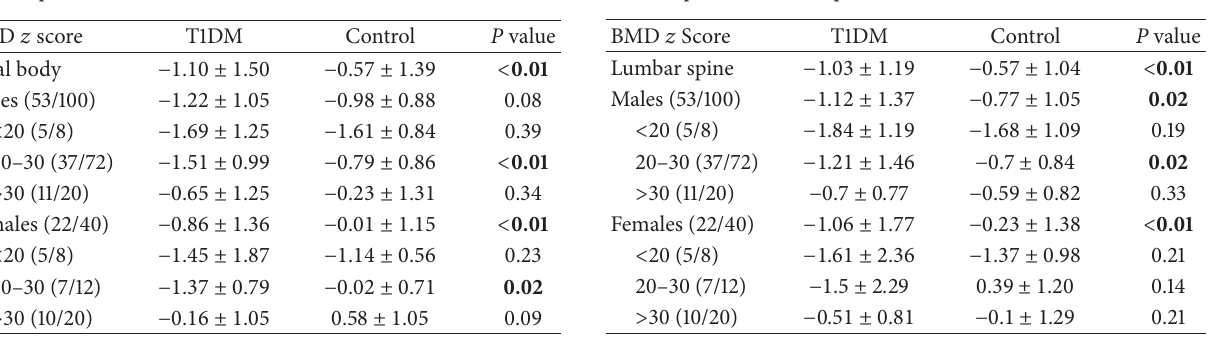
Table 4: Differences in bone mineral density 𝑧 scores in T1DM subjects and age, sex, and body mass index matched controls at lumbar spine (L2–L4) (expressed as mean ± SD).